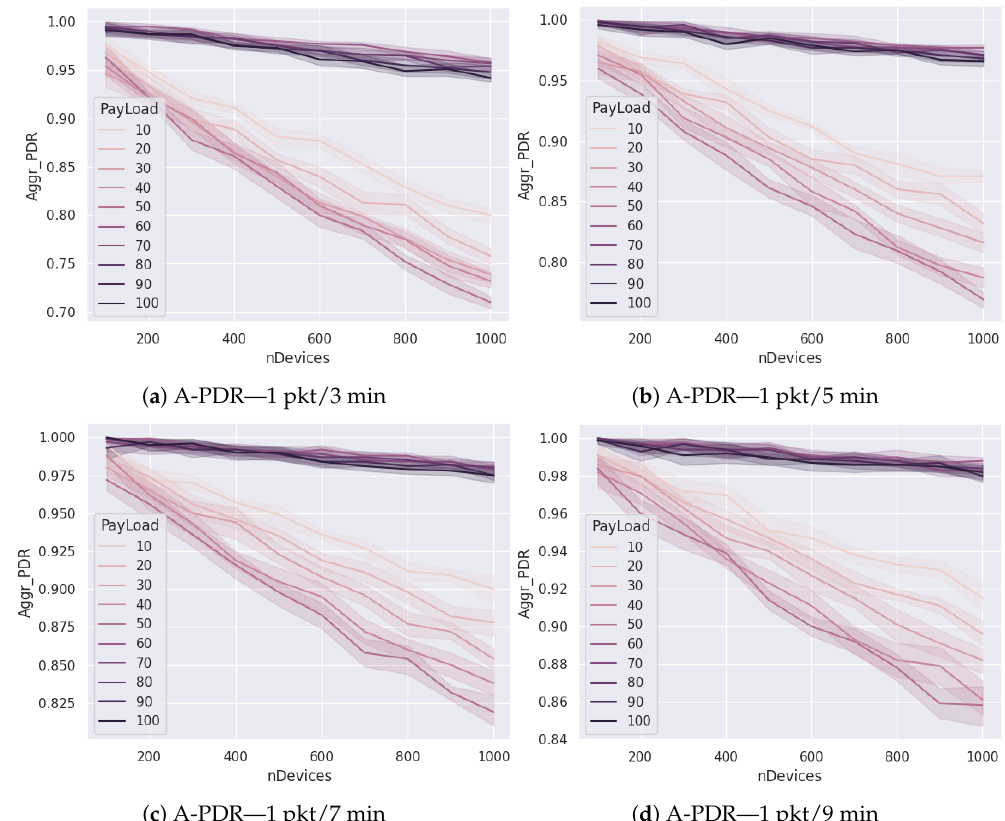
Figure 5. Aggregated PDR results for two gateways while varying the payload length with a frequency of one packet every 3, 5, 7, and 9 min—unconfirmed